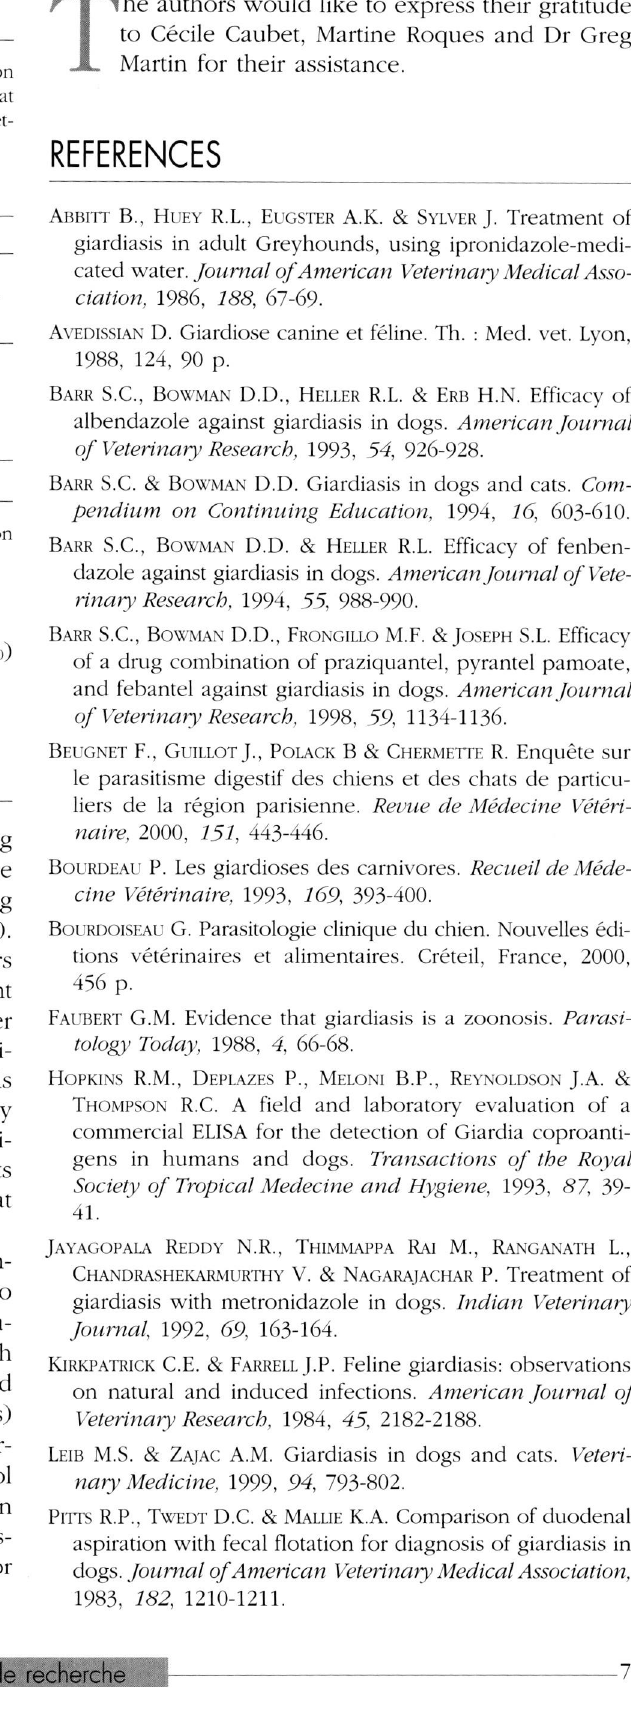
Table V. - Comparison between 1 and 2 ZSCT using the results on days 1, 2, 20 and 21. a We considered that a dog was positive if at least one on the two ZSCT was positive. * Significant difference bet ween this result and 100 % (P < 0.05).